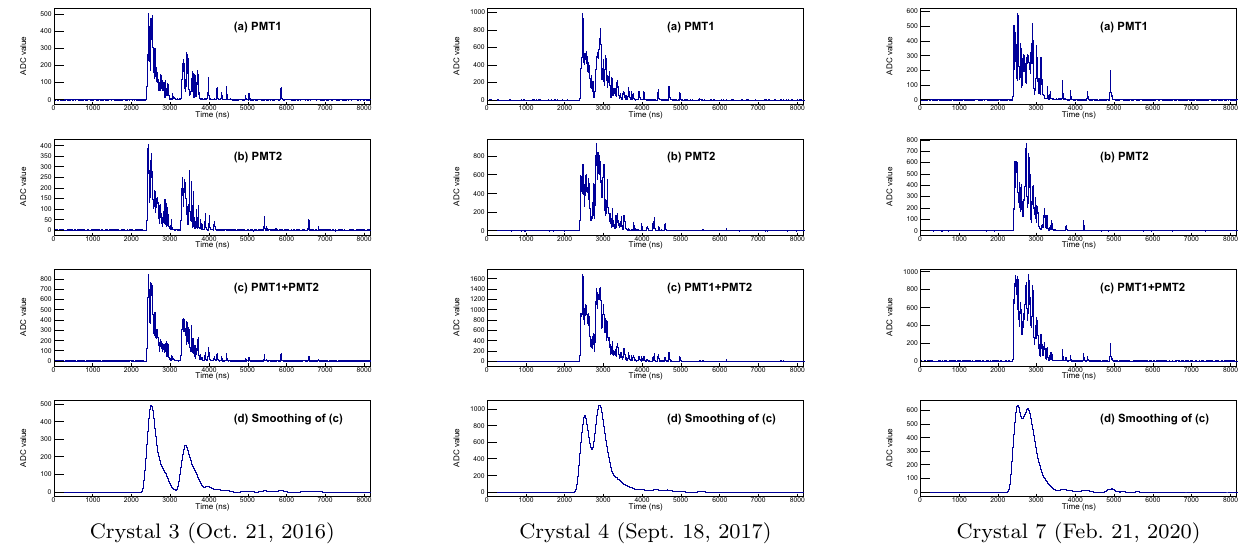
Fig. 2 Examples of selected two-pulse candidate events from different crystalsondifferentdates.( a )and( b )arethesignalsfromtheindividual PMTs, ( c ) displays the summed waveform of the two PMT signals, and